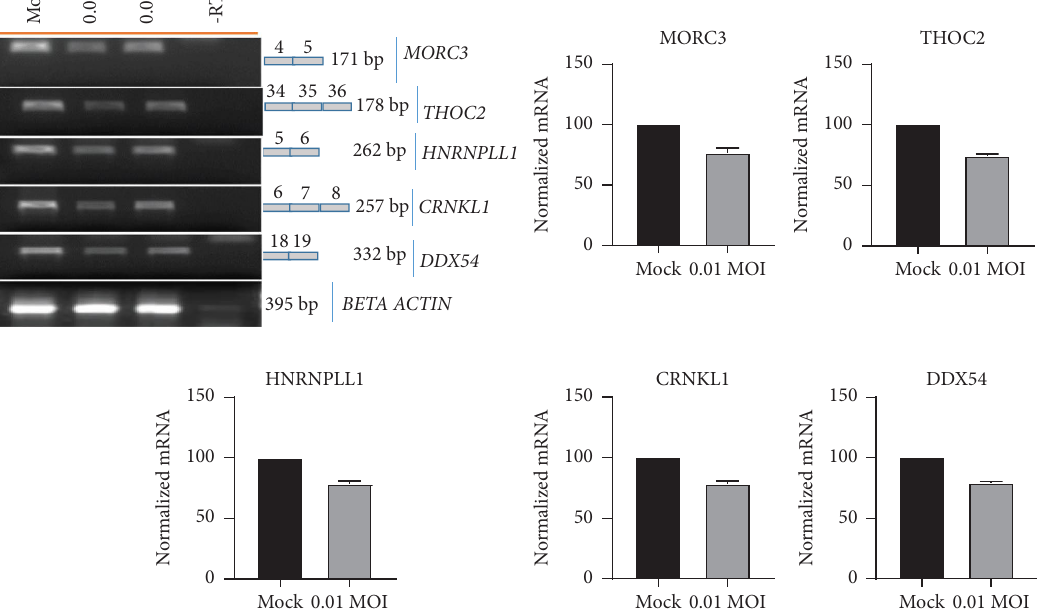
Figure 1: Efect of SARS-CoV-2 infection on host pre-mRNA splicing: Splicing modulation of MORC3, THOC2, HNRNPLL1, CRNKL1, and DDX54 in Vero cells either mock-infected or infected with SARS-CoV-2 at an MOI of